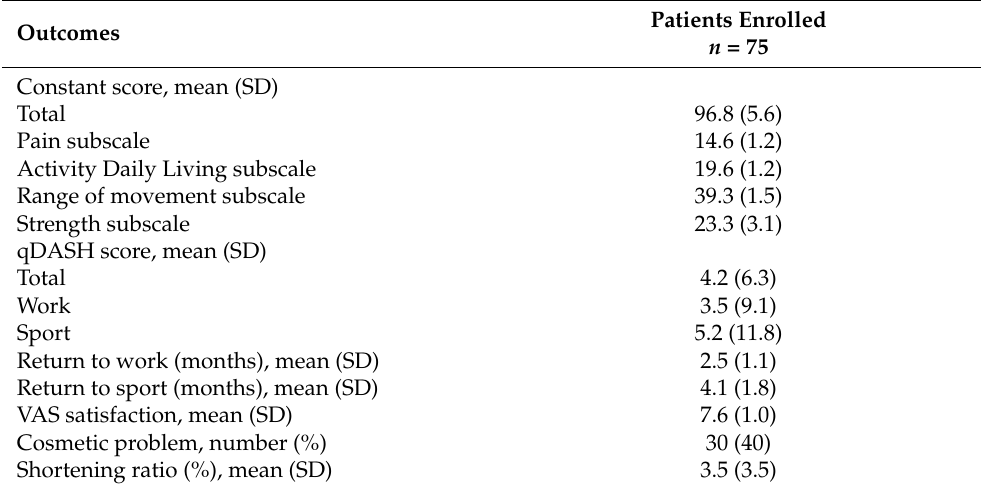
Table 3. Clinical outcomes of patients at follow-up (Mean follow-up time was 27.5 ± 7.5